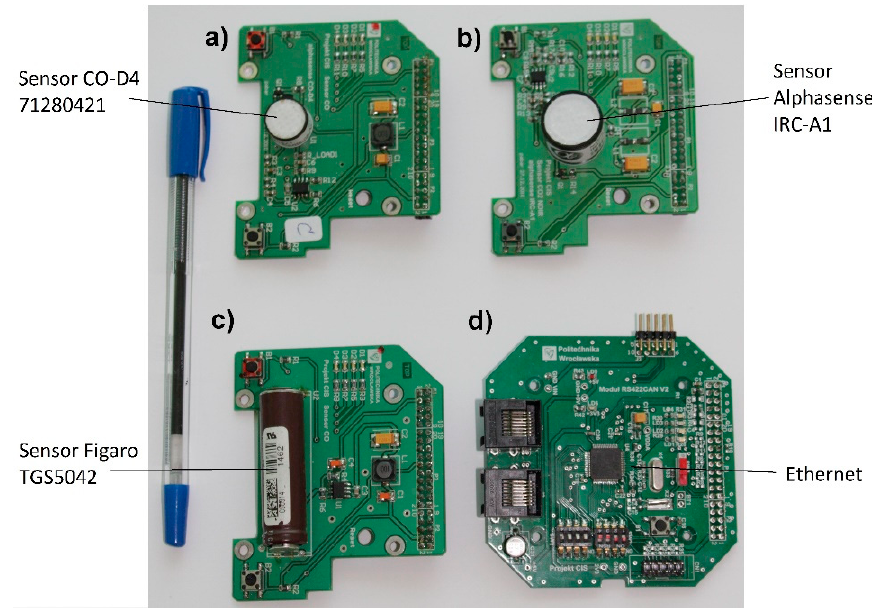
Figure 4. A top view of: ( a – c ) examples of FAM module with sensors; and ( d ) a microprocessor module.